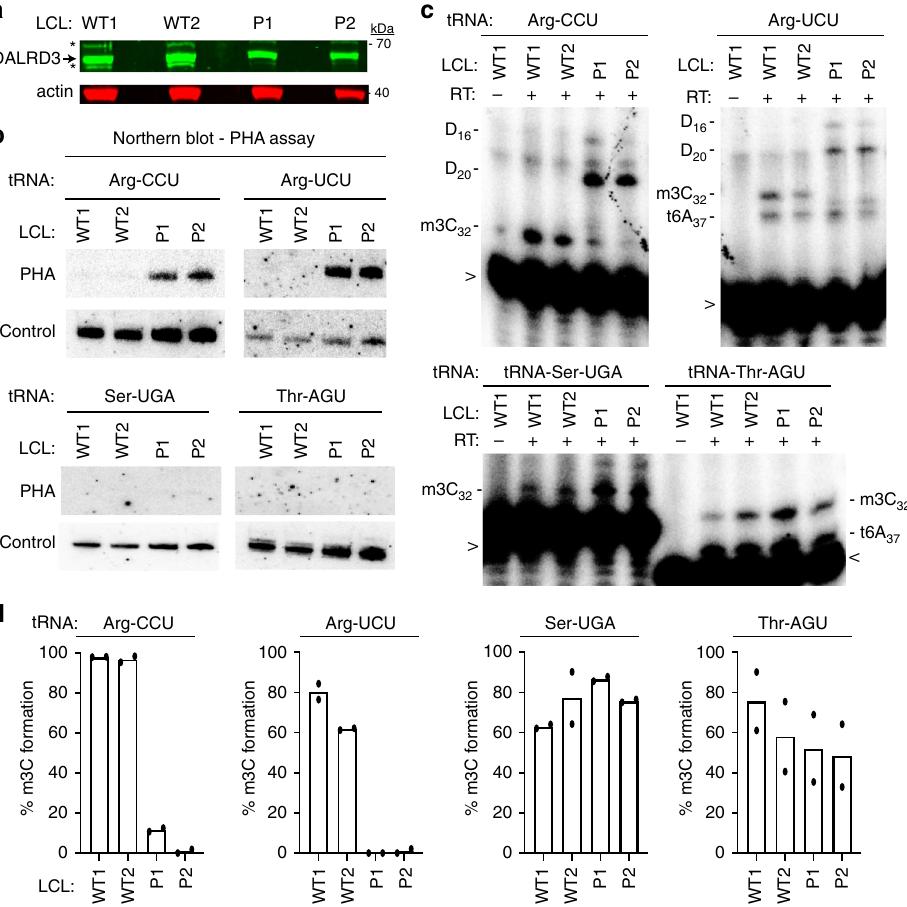
Fig. 7 Lymphoblastoid cell lines derived from patients with the homozygous DALRD3 variant exhibit de fi ciency in m3C modi fi cation in arginine tRNAs. a Immunoblot for the indicated proteins from lysates prepared from LCLs donated from wildtype (WT) individuals and patients P1 and P2 harboring the homozygous DALRD3 mutation. Asterisks (*) represent non-speci fi c bands on either side of the DARLD3 protein. Blot was repeated twice with similar results. b Northern blot analysis using PHA probes designed to detect m3C at position 32 and a control probe that hybridizes to a different area of the same tRNA. Blot was repeated three times with comparable results. c Primer extension analysis of the indicated tRNAs from the denoted human LCLs. (-RT) represents no reverse transcriptase; m3C 3-Methylcytidine; D dihydrouridine; t6A threonylcarbamoyladenosine. > labelled probe. Primer extension analysis of lymphoblastoid cell lines was repeated three times. d Quanti fi cation of m3C formation by primer extension for the indicated tRNAs. n = 2. Source data are provided as a Source data fi